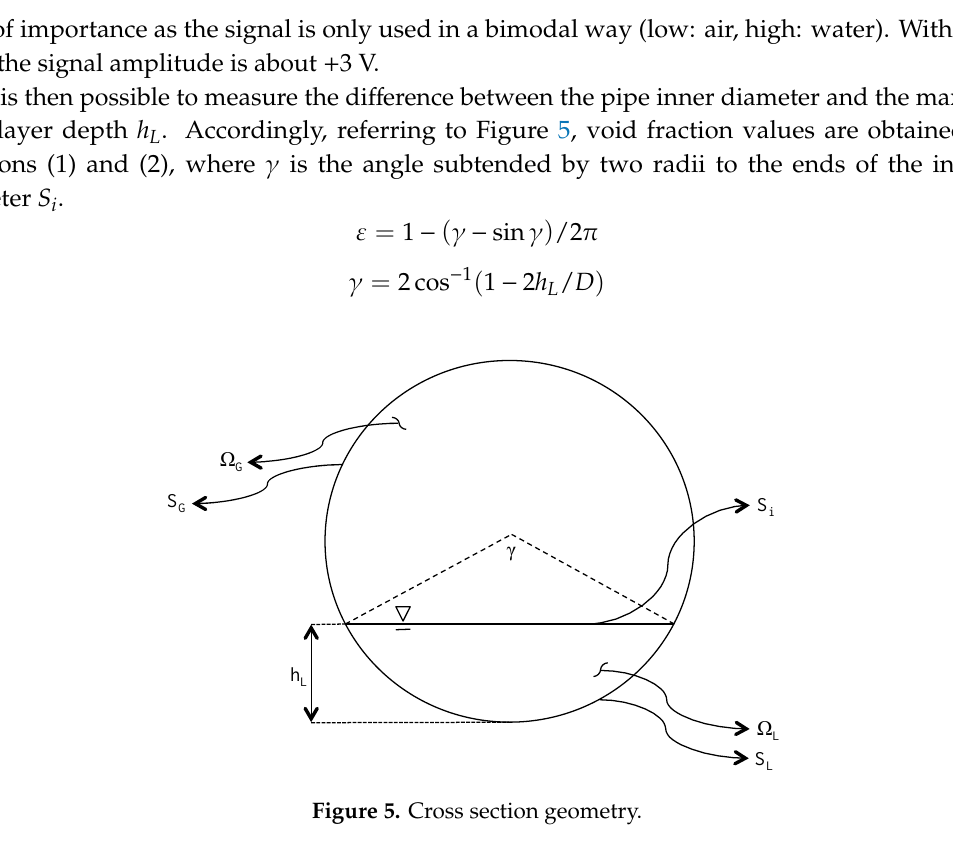
Figure 5. Cross section geometry.